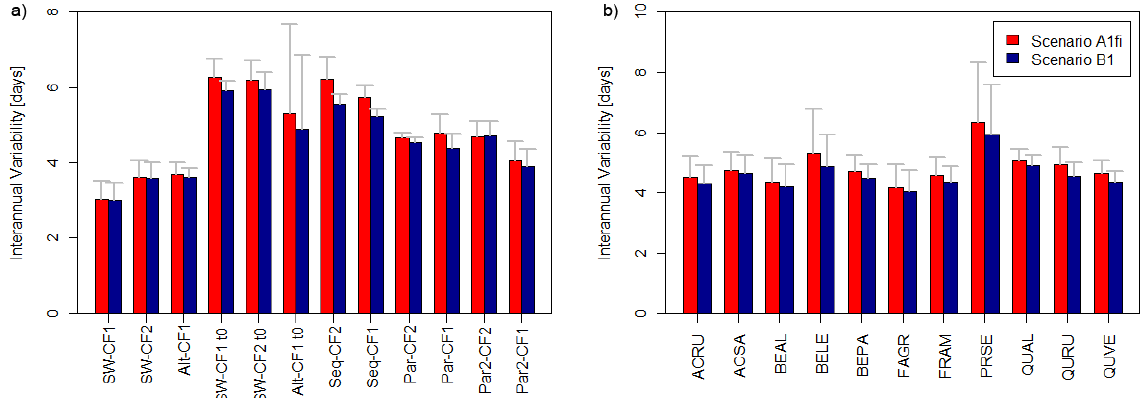
Fig. 8. Histogram of the interannual variability predicted by all model structures reported in Table 2 (left panel) and for all the species reported in Table 1 (right panel). Red histograms represent the interannual variability under scenario A1fi, blue histograms represent the interannual variability under scenario B1. The standard deviation (1sd) of the interannual variability is also reported.